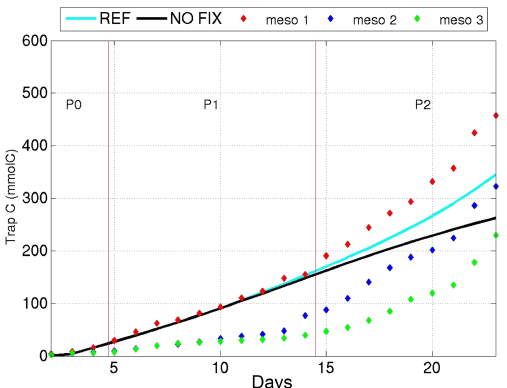
Figure 8. Evolution of C content collected in the mesocosm par- ticle traps (mmol C) in the REF simulation (blue line) and the NOFIX simulation (black line; i.e. when the N 2 fixation process is